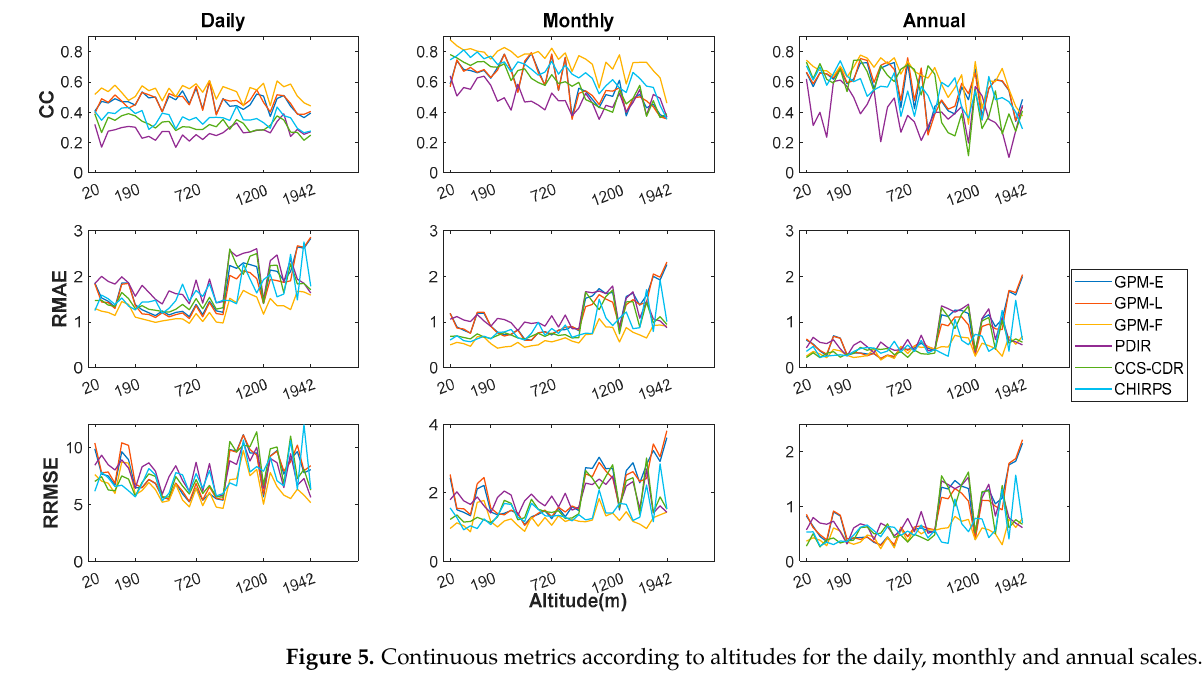
Figure 5. Continuous metrics according to altitudes for the daily, monthly and annual scales.